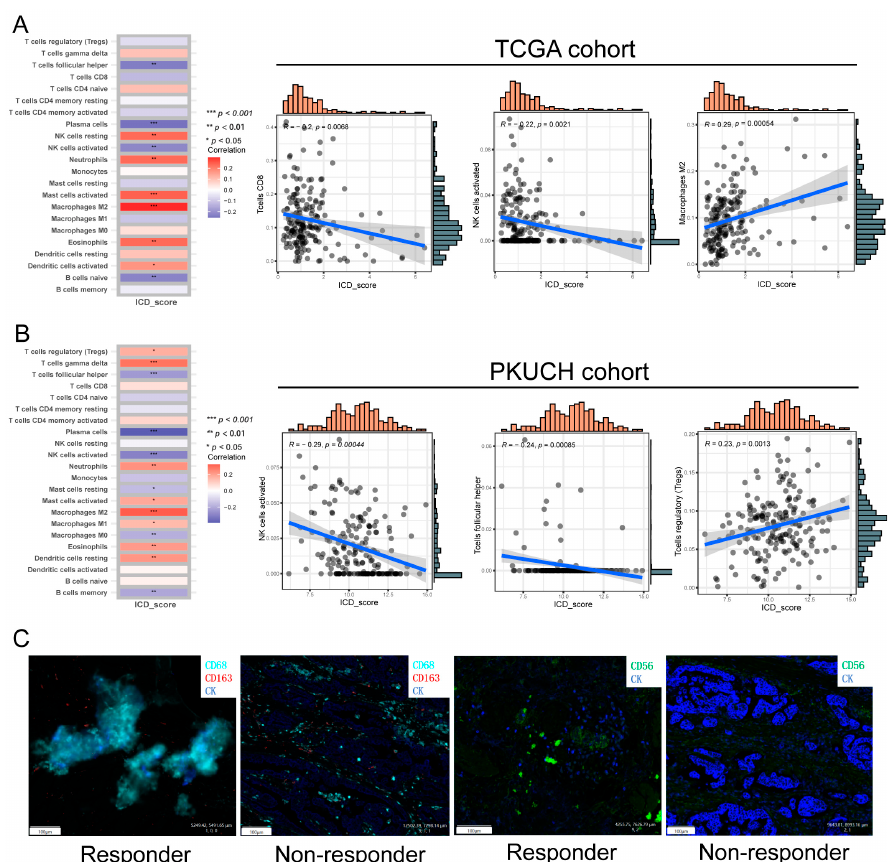
Figure 7. Evolution of the TIME in distinct ICD_score groups. ( A , B ) Correlations between ICD_score and immune cell types in TCGA cohort and our PKUCH cohort, respectively. ( C ) Representative mIF ‐ staining pictures of responder/low ‐ and non ‐ responder/high ‐ ICD_score tumors to neoadjuvant chemotherapy plus PD ‐ 1 blockade. p values were shown as: * p < 0.05; ** p < 0.01; *** p < 0 ∙ 001.